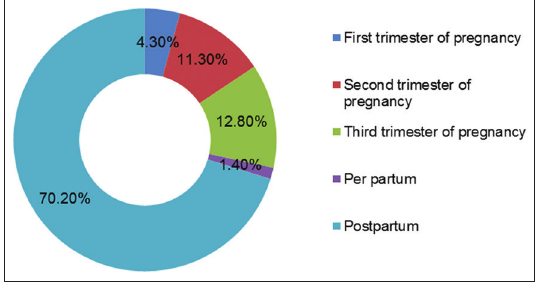
Figure 1 : Distribution of maternal deaths as a function of obstetrical period in Dori Hospital, Burkina Faso, 2014-2016